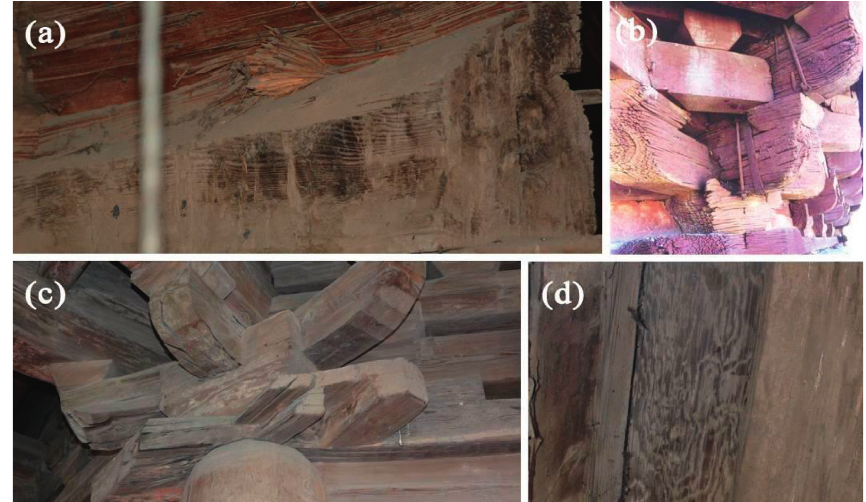
Figure 1: Damages on the surface of wooden components in Yingxian Wooden Pagoda. There are decreased effective bearing areas of (a) beams, (b) Dou-Gong brackets, and (c) smaller Dou brackets, and (d) the surfaces of most columns have lower hardness and density, which are attributed to the decay on the surface of the